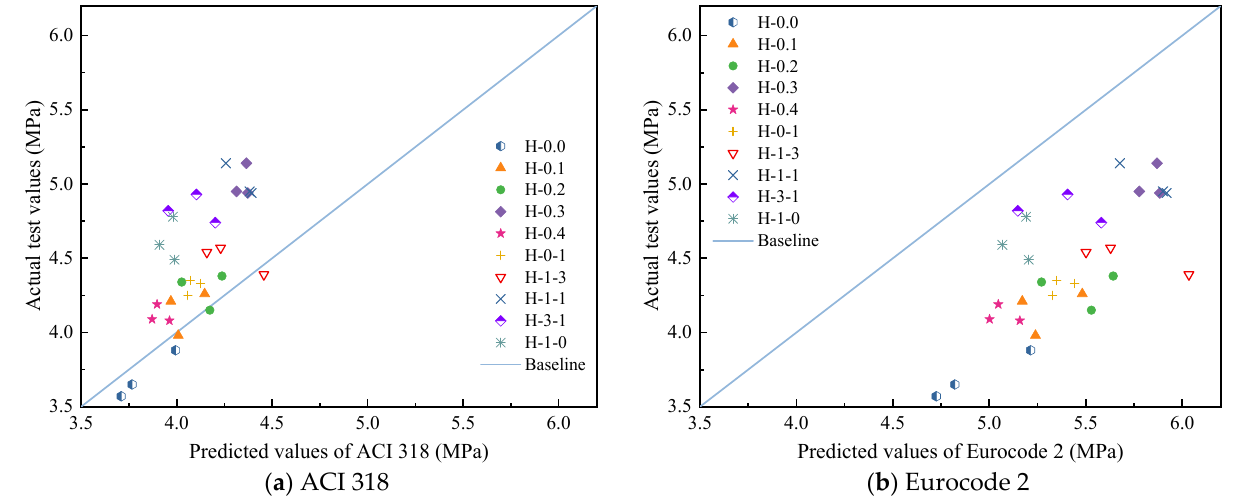
Figure 12. Comparison of test values and code predictions values of flexural strength.